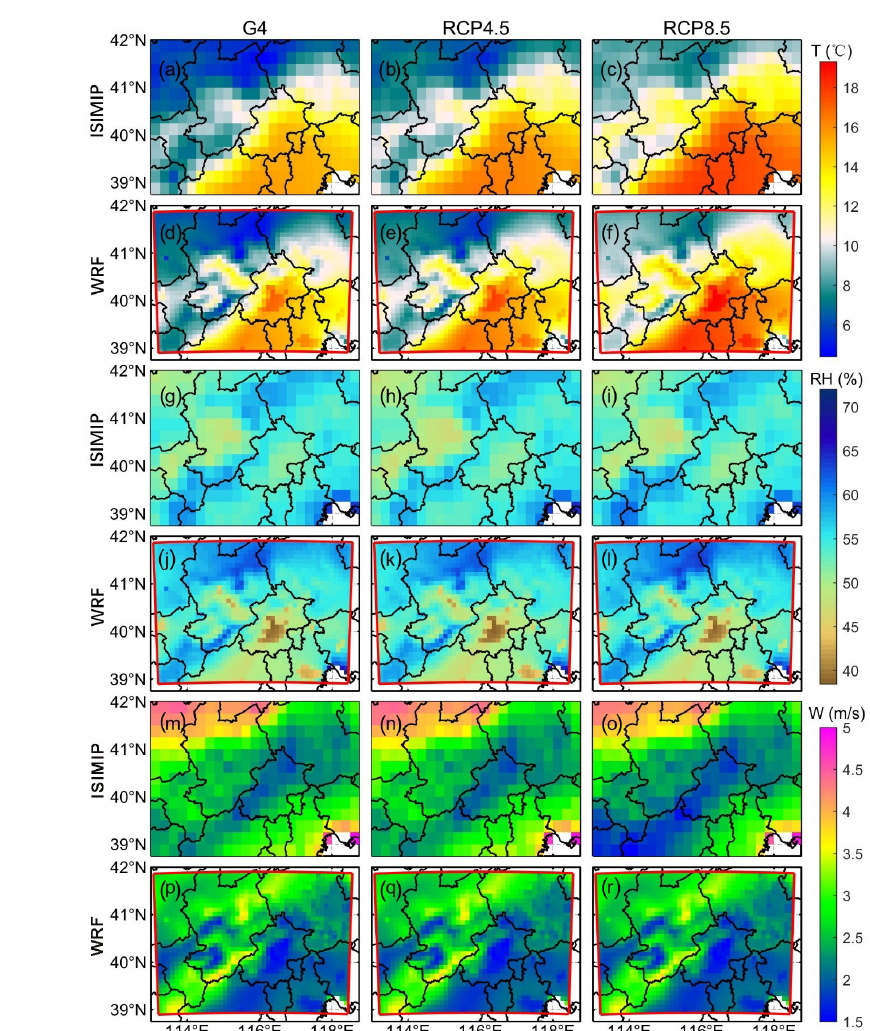
Figure 9. The spatial distribution of ensemble mean 2m temperature (a–f) , relative humidity (g–l) and 10m wind speed (m–r) under G4, RCP4.5 and RCP8.5 scenarios based on ISIMIP-ESM and WRF-QDM-ESM results during